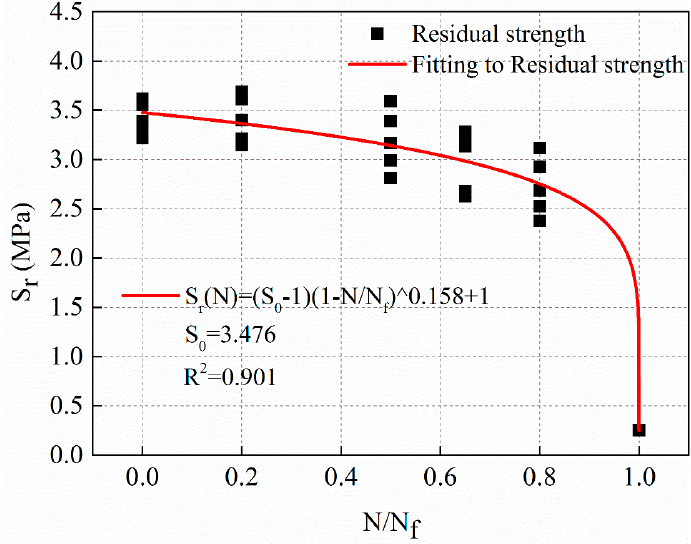
Figure 12. The decay law of residual strength with stress levels of 0.25 MPa.